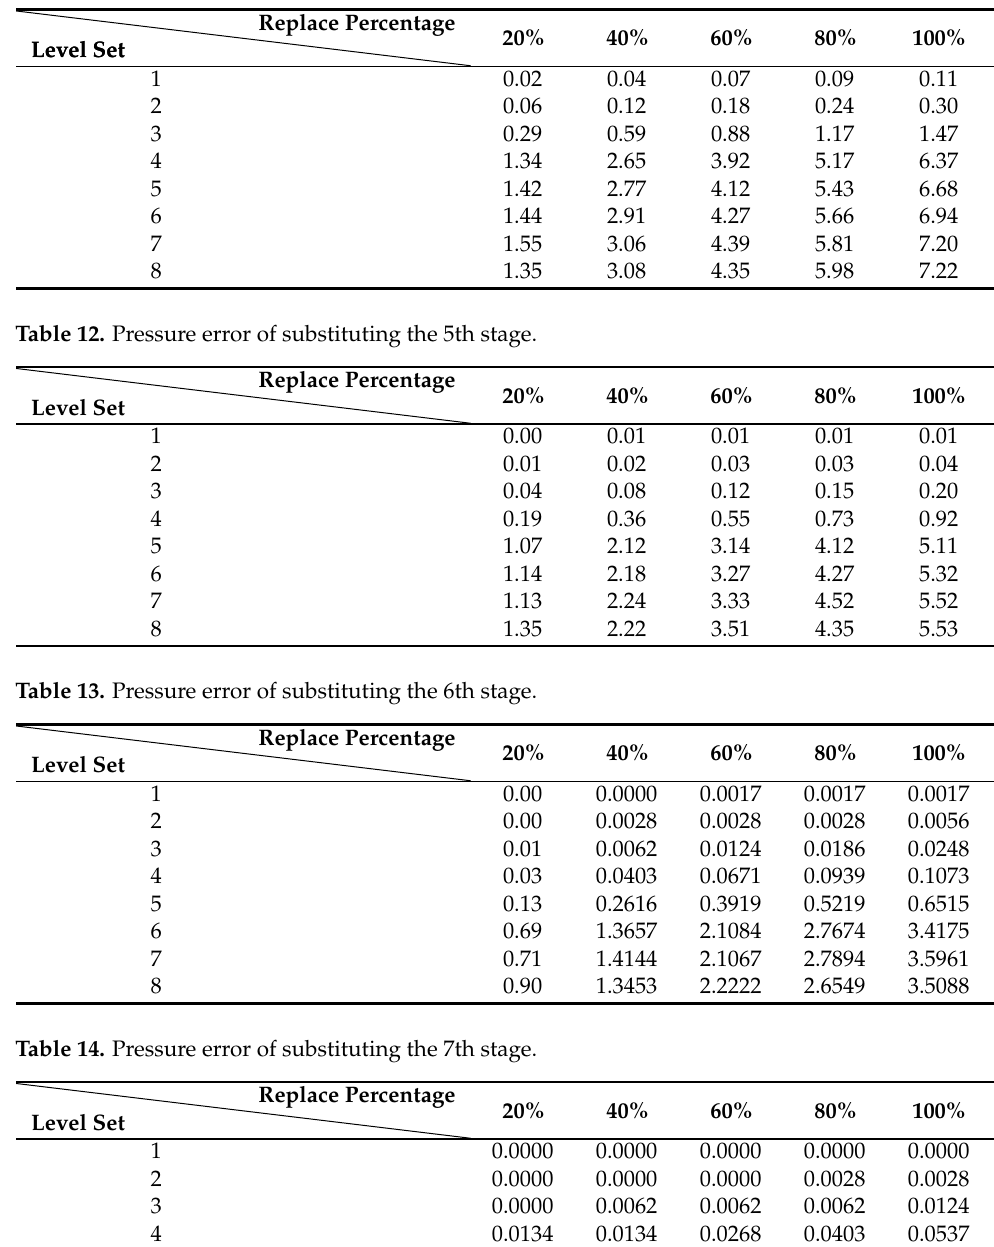
Table 11. Pressure error of substituting the 4th stage.